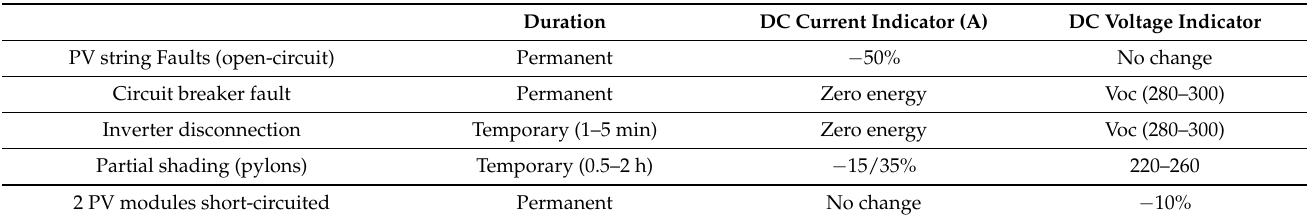
Table 11. Considered faults with their